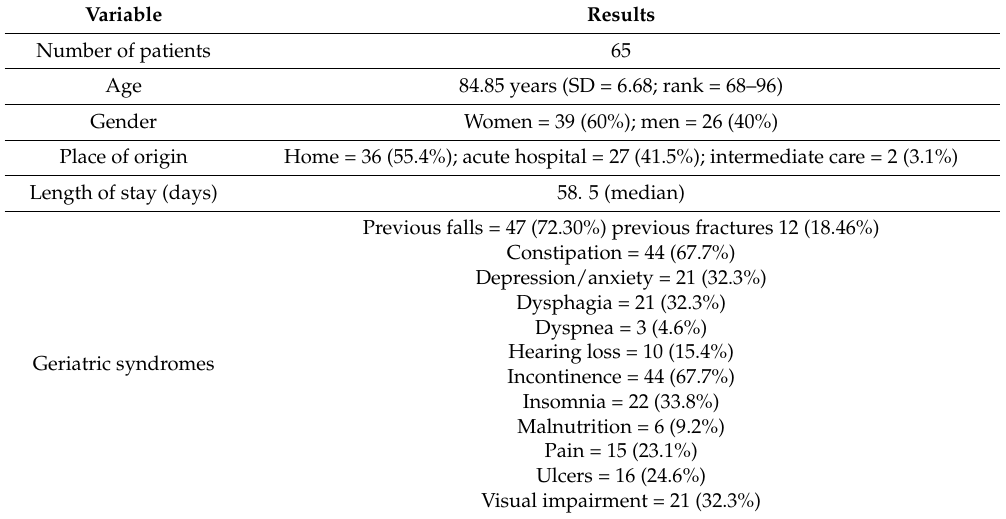
Table 1. Baseline characteristics of the patients